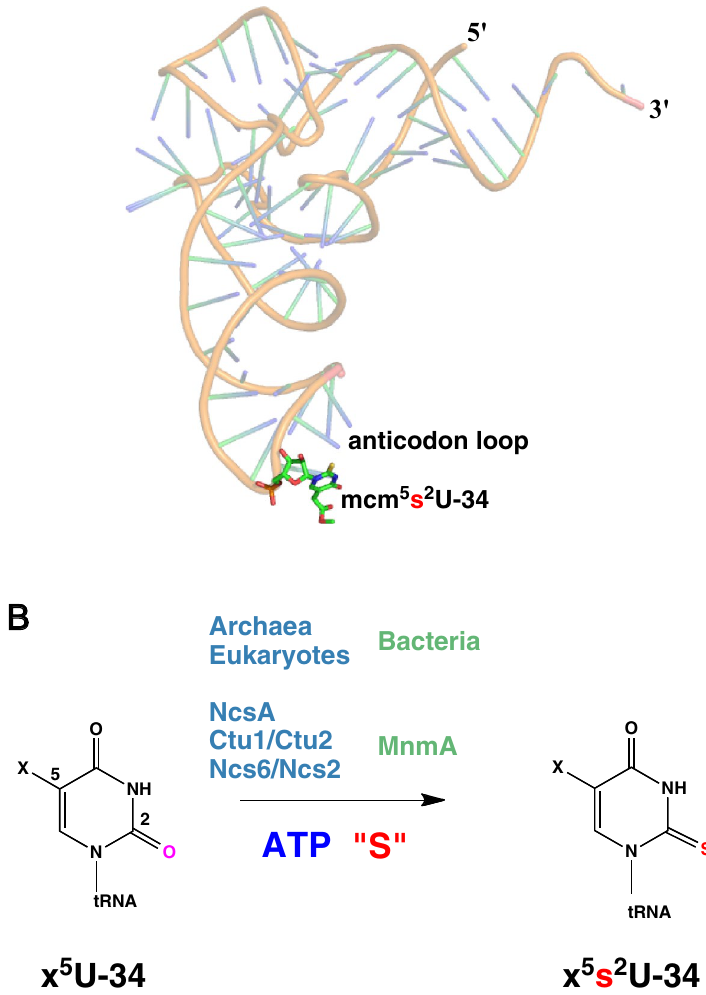
Figure 1. U34-tRNA thiolation. ( A ) Location of mcm 5 s 2 U34 (in stick representation) in human tRNA Lys3 (PDB code 1FIR). ( B ) Reaction catalyzed by U34-tRNA thiolases. The modification at the C5 position (noted x) varies upon the organism (see